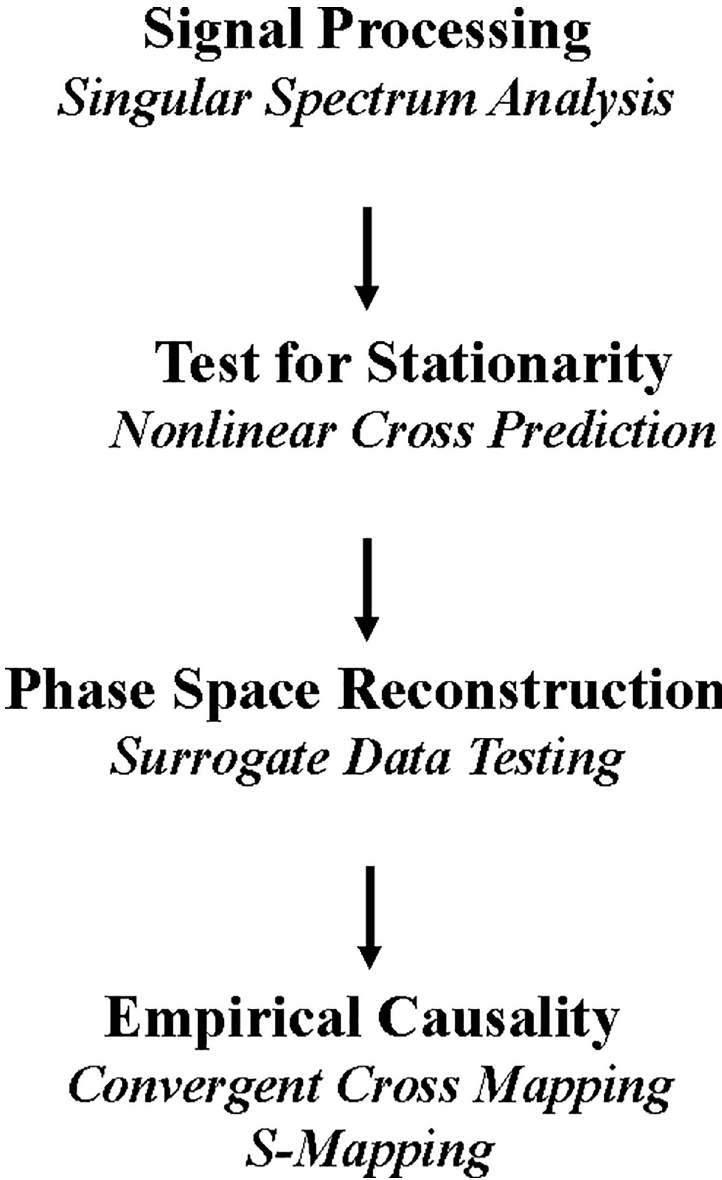
Fig 3. A framework for reconstructing real-world market dynamics from observed time-series records with NLTS. We implement Nonlinear Time Series Analysis (NLTS) with a sequential framework based on an extensive review of sound empirical practices recommended in the